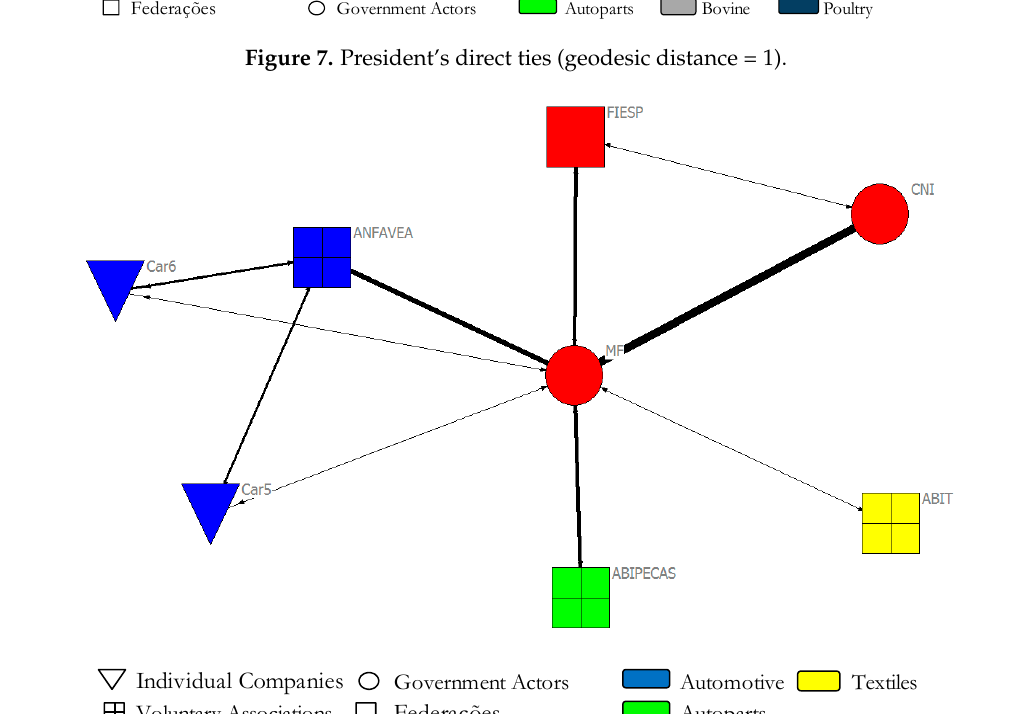
Figure 8. Direct relationships between the Economic Ministry (MF) and business associations (geodesic distance = 1).